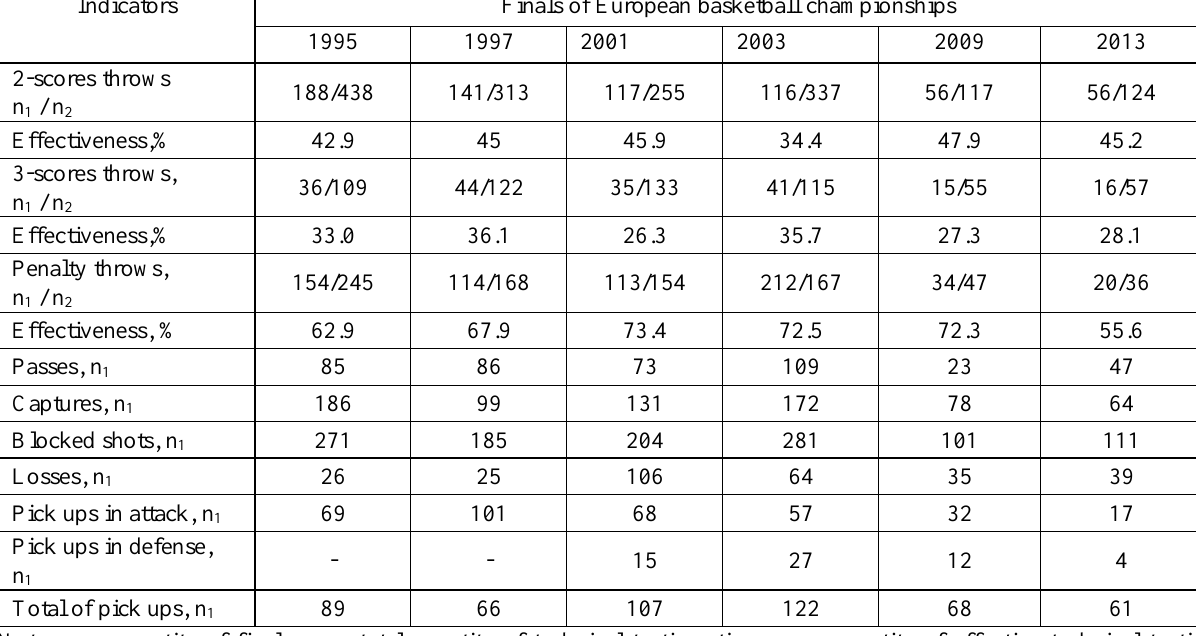
Indicators of effectiveness of basketball combined team of Ukraine (women) in finals of European championships 1995- 2013,